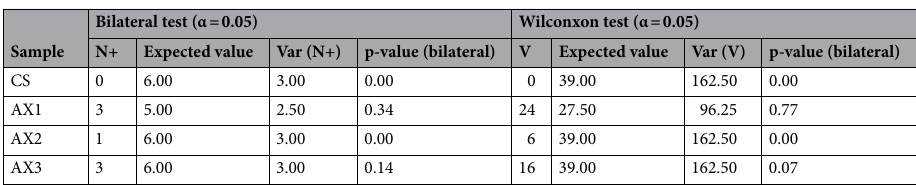
Table 3. Results of a non-parametric test applied to n-alkane distributions. H 0 is assumed when p-value > α.